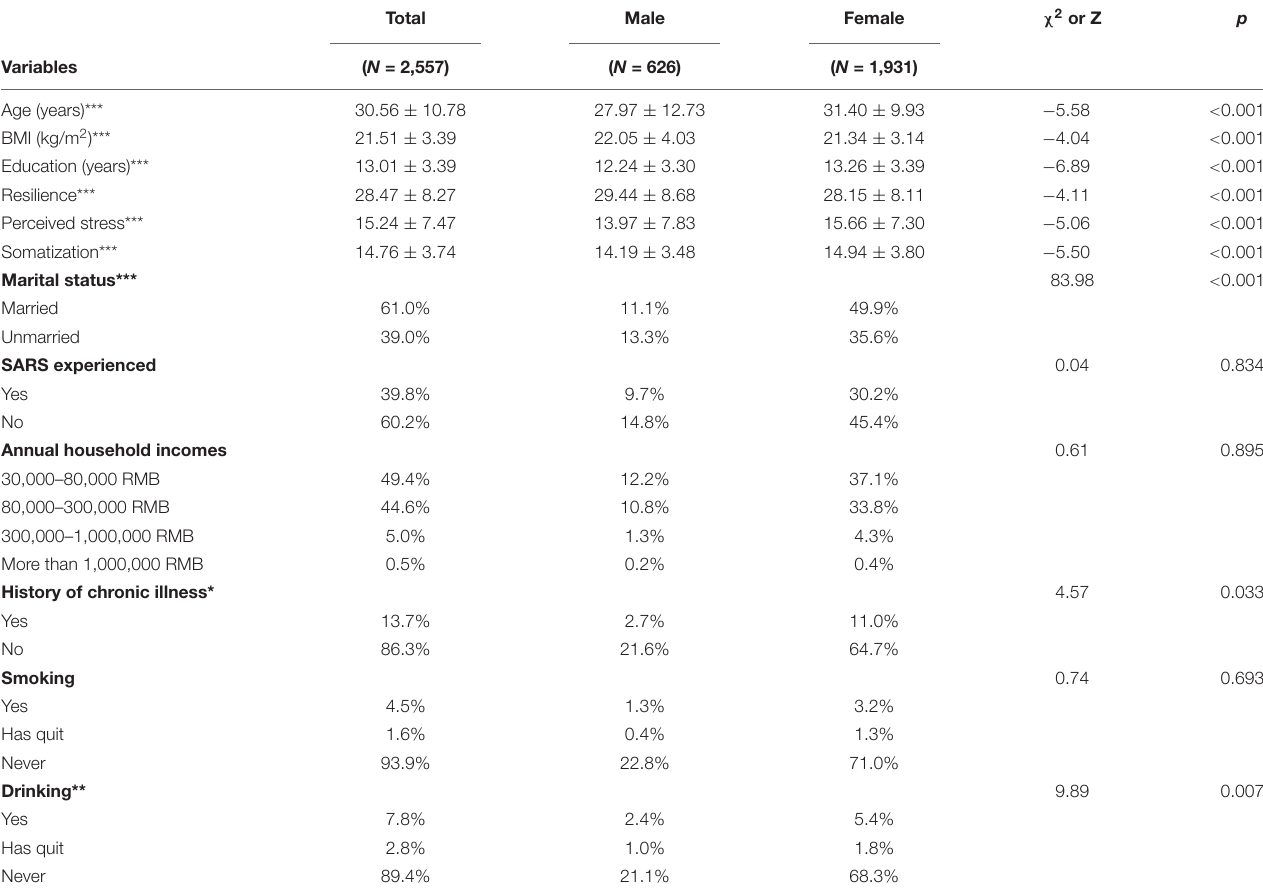
TABLE 1 | Descriptive statistics and differences of sex for all